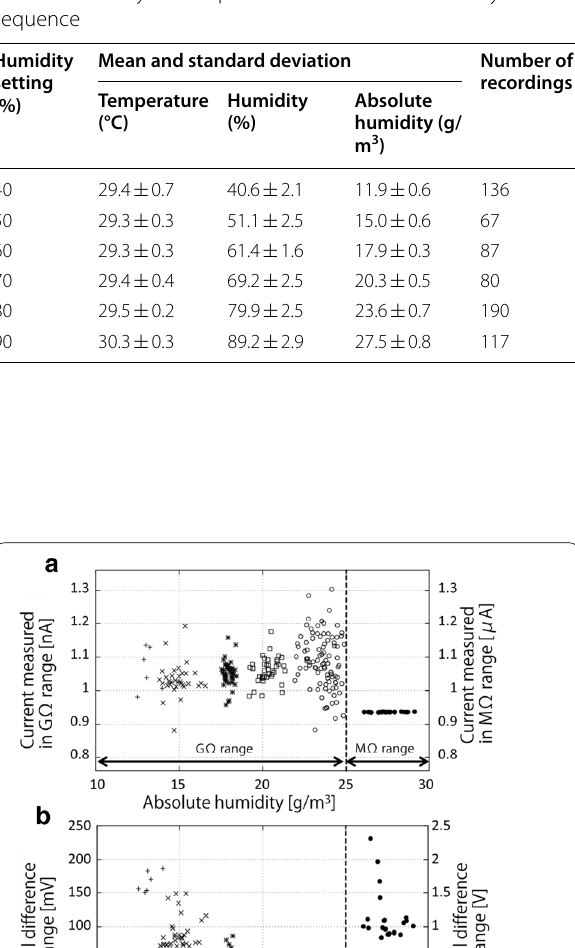
Fig. 7 Representative time-series data for resistance, current, and potential difference. The results are those measured for 600 s at 40% relative humidity and 30 °C using the measurement layout in Fig. 3. a Resistance between C 1 and C 2 measured by a resistance meter. b Current measured by an ammeter. c Potential difference between P 1 and P 2 . The injected current took several tens of seconds to stabilise after measurement started. It was initially larger than the specified current used by the resistance meter to measure resistance in the GΩ range, and was interpreted as inrush current. This inrush current caused the resistance also to take several tens of seconds to stabilise, after which resistance increased. This was interpreted as charging. The minimum in the resistance data for 600 s is therefore considered the most representative value, because the effects of inrush current and charging are likely smallest. Current and potential difference were taken as their values at the time when resistance was lowest, as indicated by the dashed line